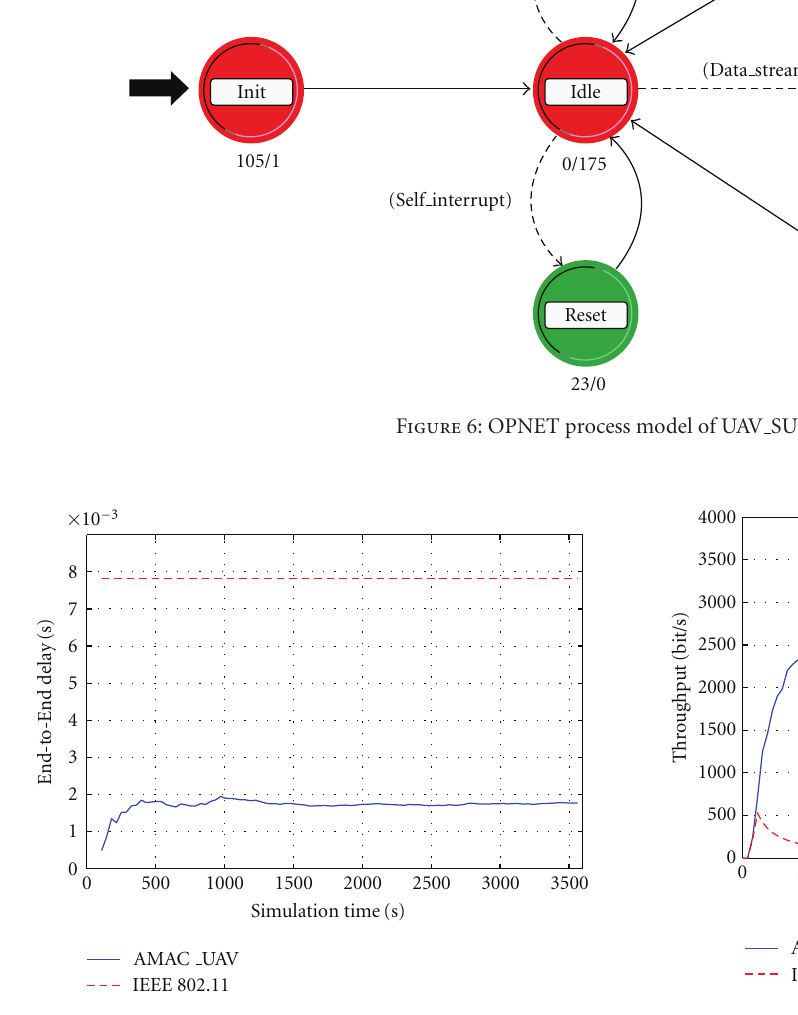
Figure 7: End-to-end delay of a MANET of 4 UAVs. Figure 8: Throughput of a MANET of 4